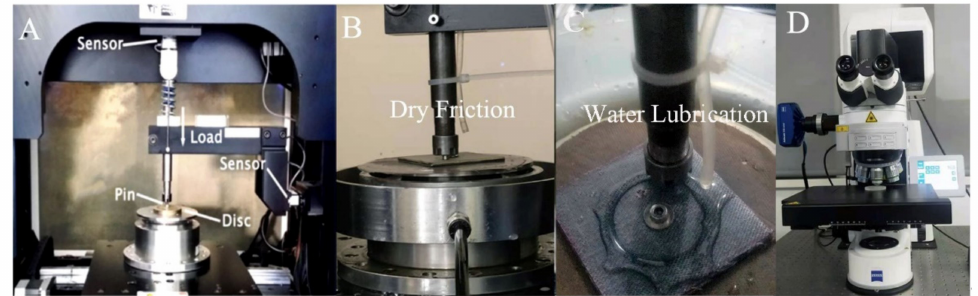
Figure 2. ( A ) The schematics of pin-on-disk tribometer, the photos of ( B ) friction test under dry friction, ( C ) friction test under water lubrication and ( D ) laser scanning microscope.